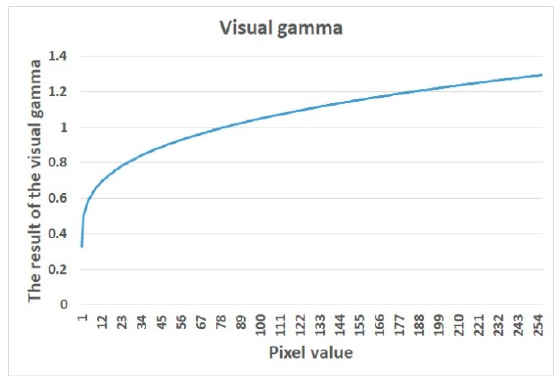
Figure 3. Characteristic curve of the visual gamma values.